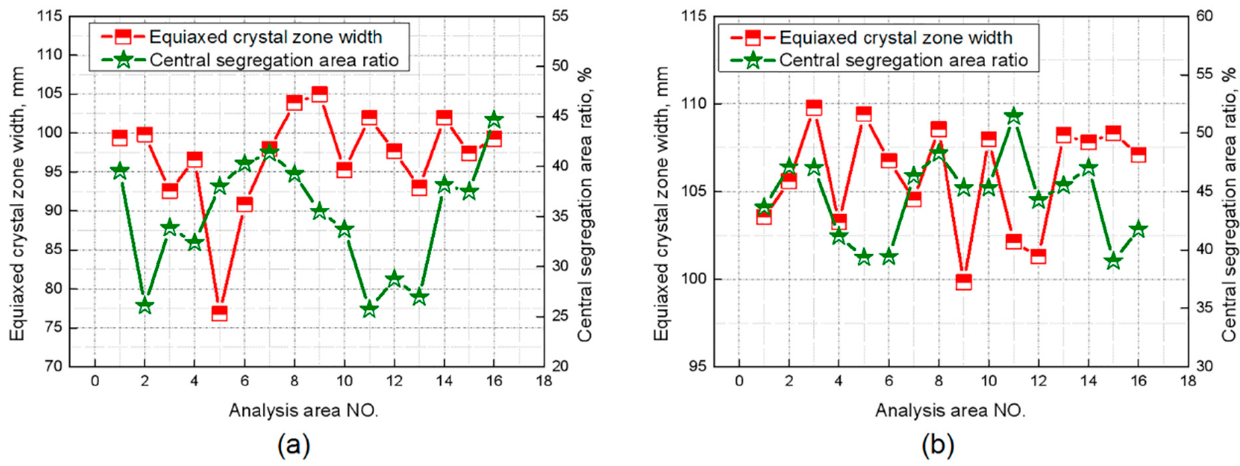
Figure 4. Calculated equiaxd crystal zone width and central segregation area ratio of billet No. 1 ( a ) and billet No. 2 ( b ).